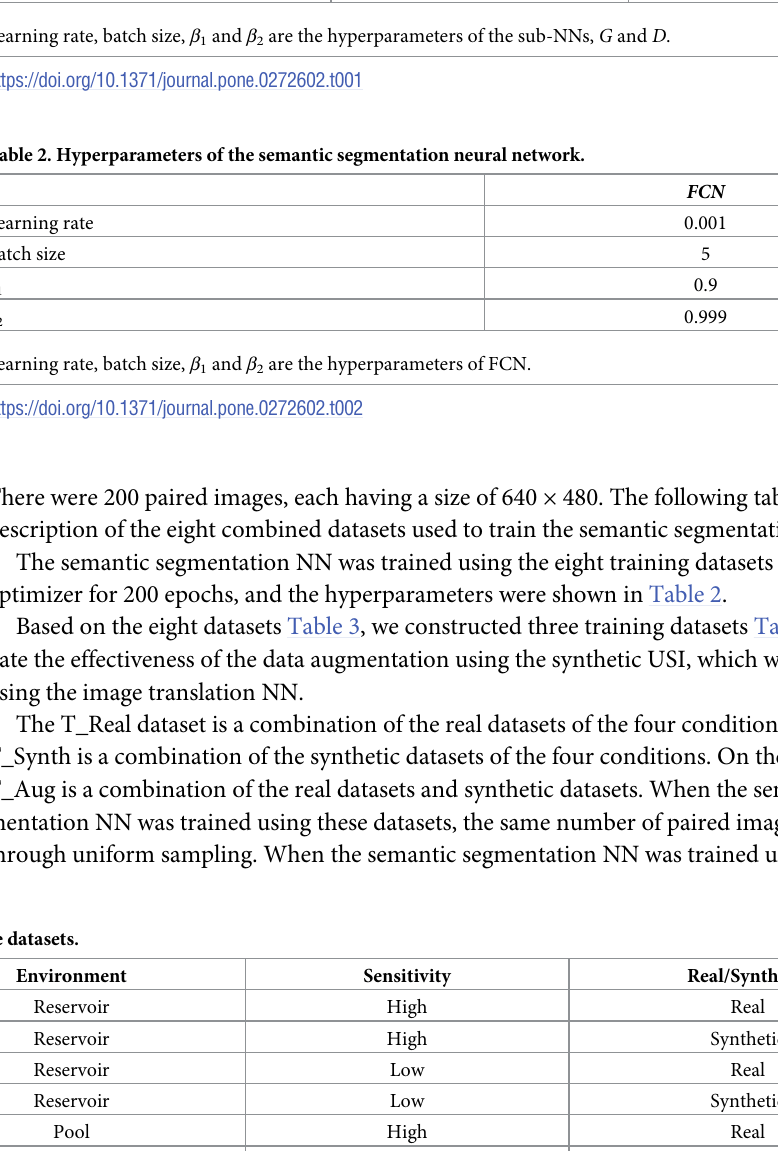
Table 3. Real and synthetic underwater sonar image